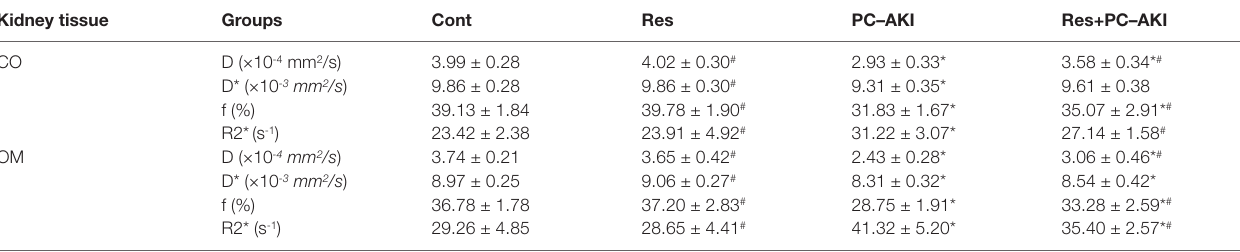
TABLE 2 | Summary of IVIM parameters and R2 * for kidneys of rabbits with different treatments. Kidney